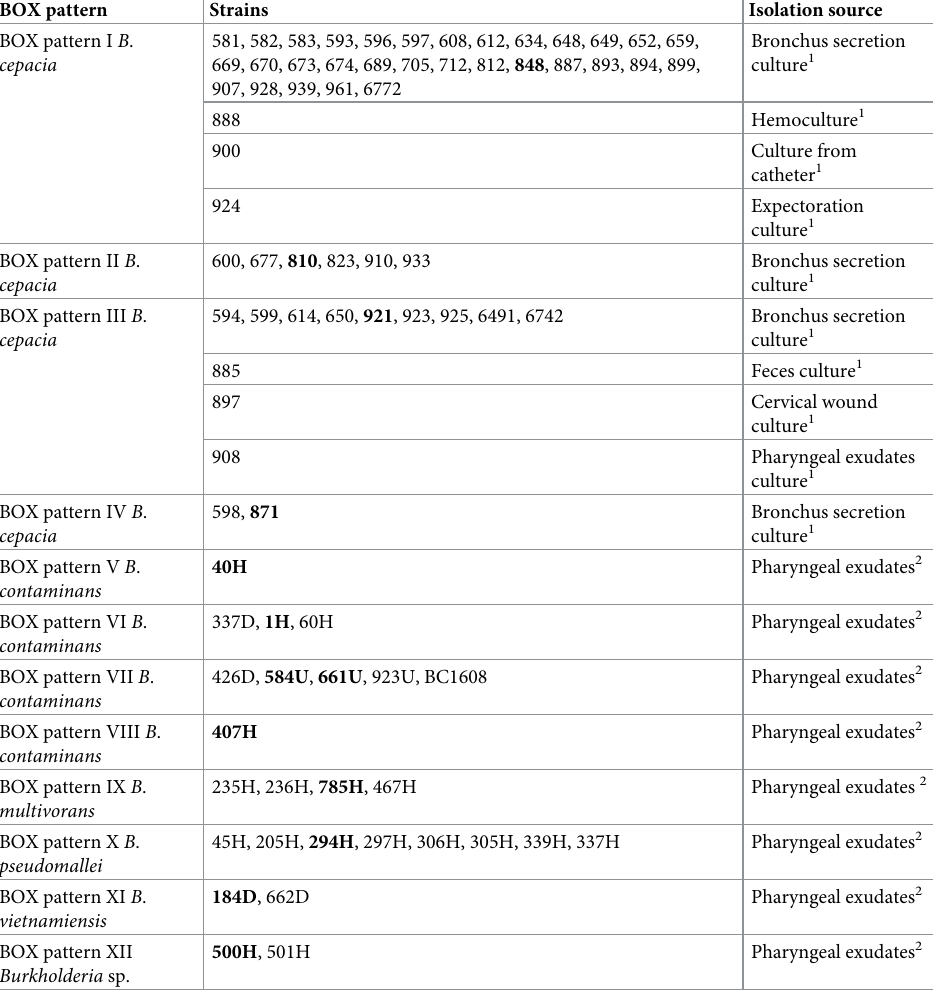
Table 1. Burkholderia strain list and BOX pattern isolated from patients at two hospitals in Mexico,